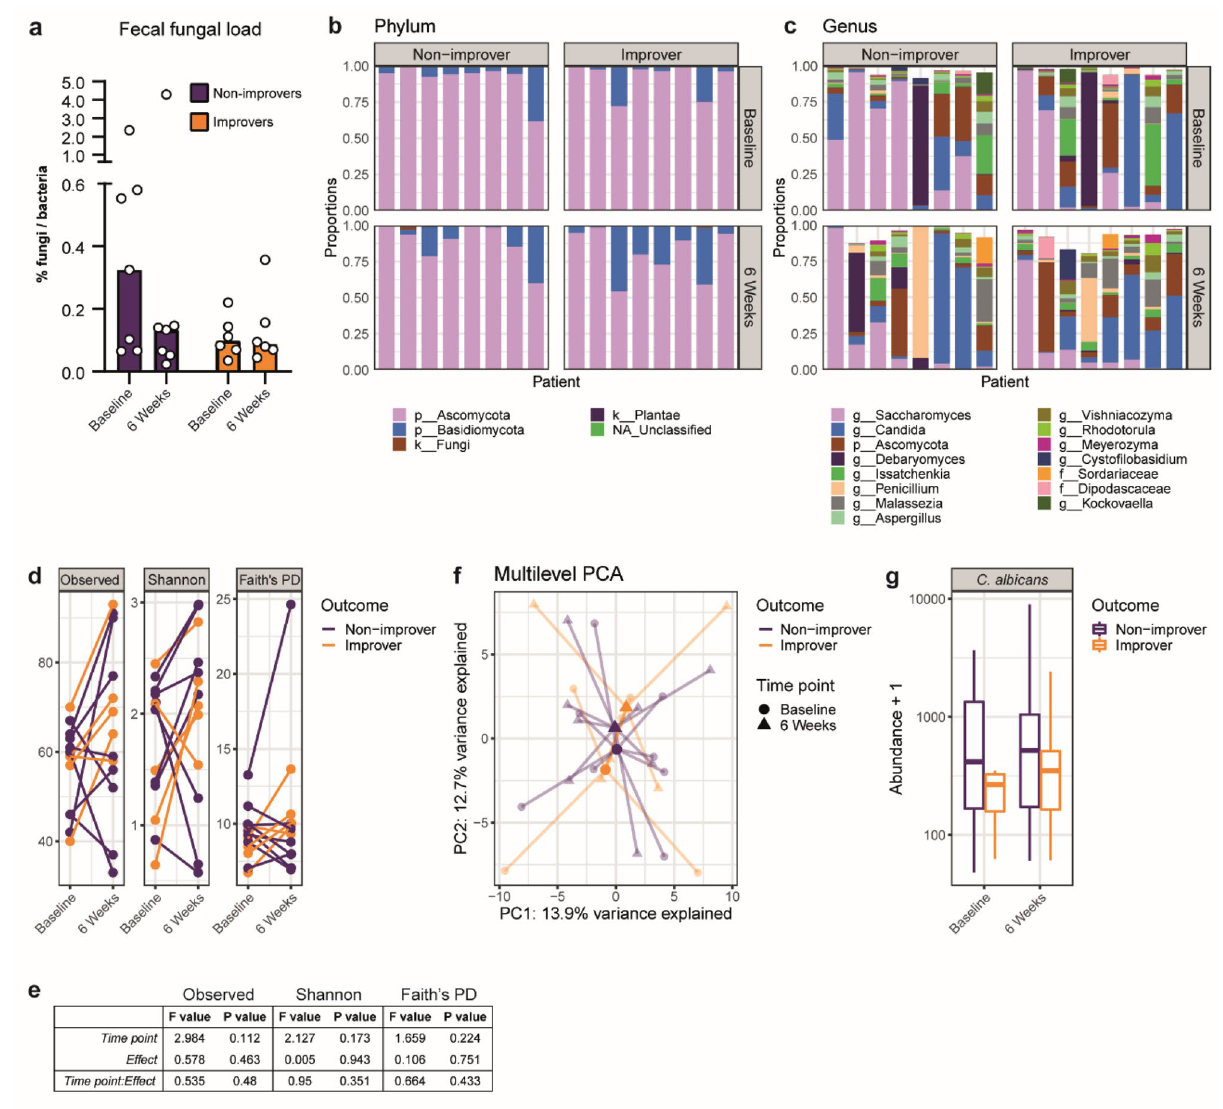
Figure 1. Fecal mycobiota analysis reveals no differences with respect to sensitivity status. ( a ) Fungal load determination by FungiQuant qPCR. ( b ), ( c ) Taxonomic analysis of sequenced samples on relative abundance of top 5 phyla ( b ) and top 15 genera ( c ). ( d ), ( e ) α-diversity metrics according to number of observed species, Shannon diversity, Faith’s Phylogenetic Diversity (PD). Linear Mixed Effects model results presented in ( e ). ( f ) Community analysis by multilevel principal component analysis. Bold symbols represent centroids of each sample group, while light symbols indicate individual samples. ( g ) Abundance of Candida albicans based on ITS1 sequencing